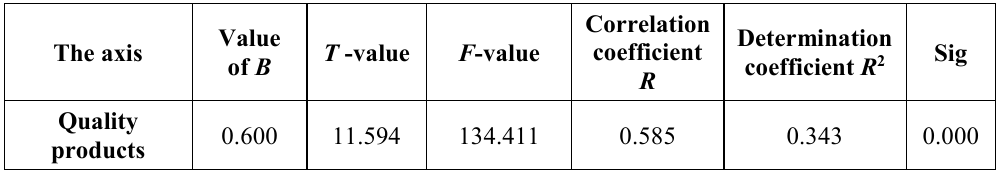
Table 3. Result of Simple Regression Analysis to Test the Impact of